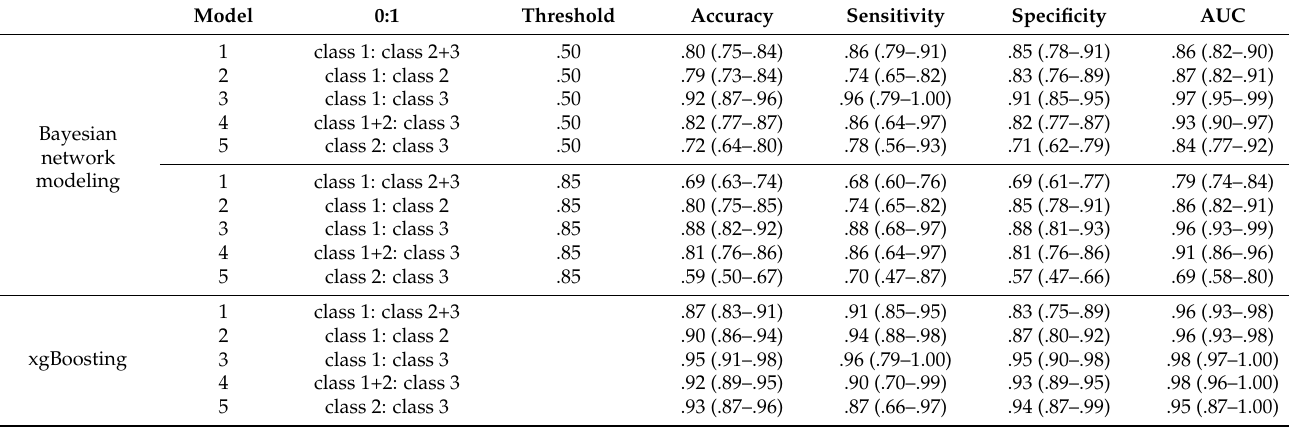
Table 4. Predictive performance of children’s EFD